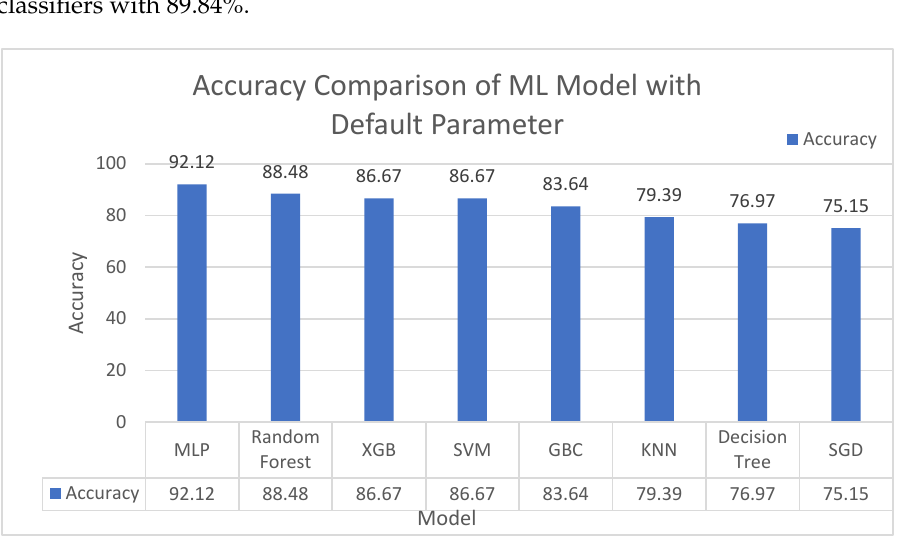
Figure 6. Accuracy Visualization of ML Classifier w.r.t Default Parameters.